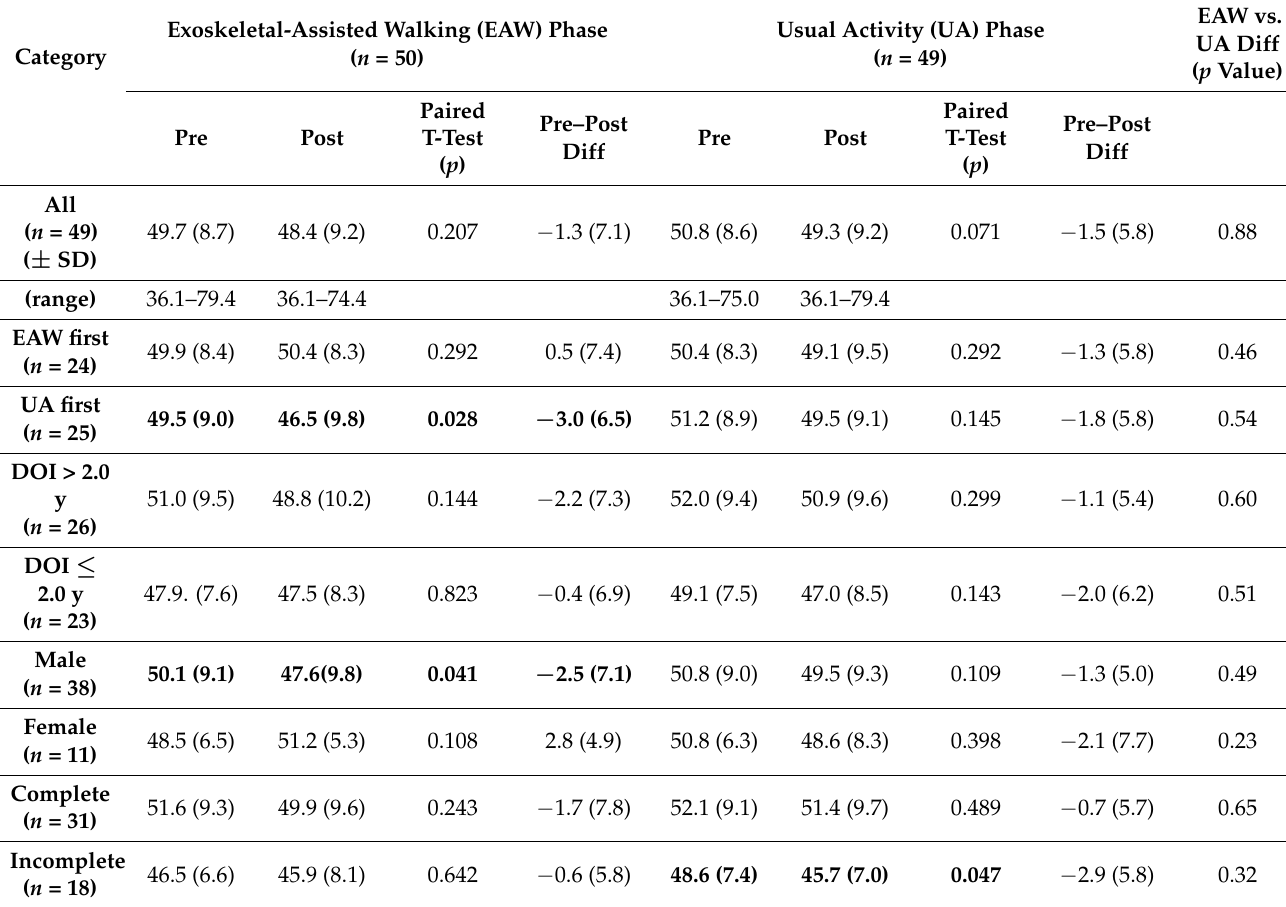
Table 2. Bowel Management Item Bank from the Spinal Cord Injury Quality of Life